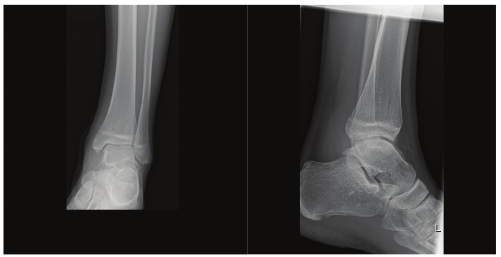
Figure 6: Plain radiography, anteroposterior and mediolateral view of the ankle joint at follow-up.